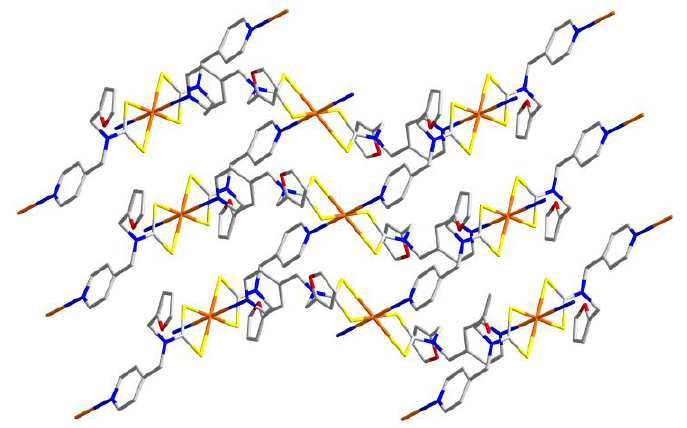
Figure 17. Two-dimensional aggregation in {Hg[S 2 CN[CH 2 (4-py)]CH 2 (2-furyl)] 2 } n ( 183 ).